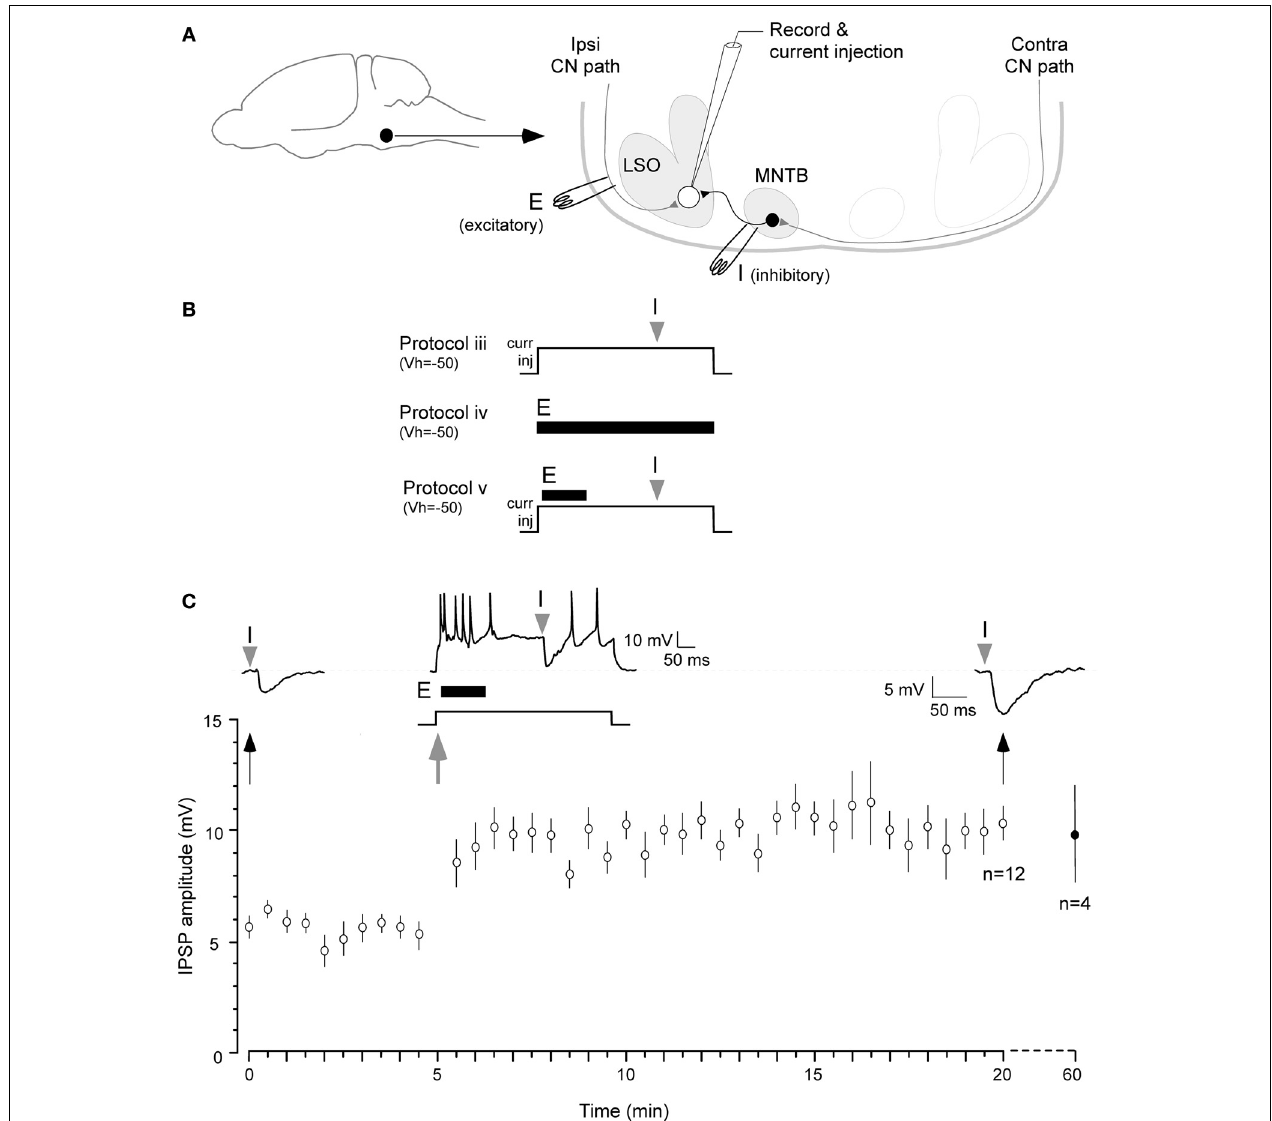
FIGURE 1 | Iaqnduction of inhibitory LTP in P12–15 day neurons. (A) A schematic of the LSO circuit in brain slice preparation. Filled circle and arrow indicate auditory brainstem. E: ipsilateral excitatory pathway from cochlear nucleus (CN), I: MTNB pathway activated by contralateral CN. (B) Three of the stimulus protocols are shown (see Results for details). Only Protocol v was effective in inducing iLTP, as shown in (C) . (C) A pre-conditioning MNTB-evoked IPSP evoked by MNTB stimulus (I). Such IPSPs were obtained at 0.033Hz for 5min at V HOLD = − 50mV (baseline). A single suprathreshold depolarization (500ms, + 5–10pA) injection was used to trigger neuronal firing by up to 50Hz. The ipsilateral excitatory afferents